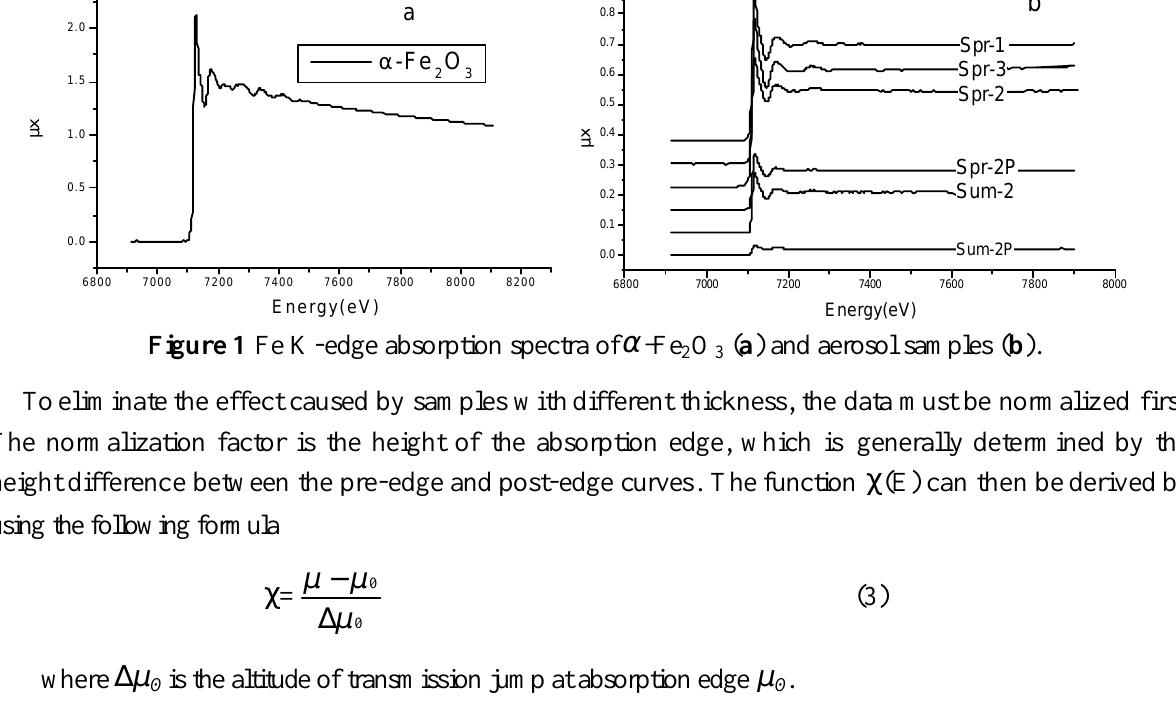
Figure 1 Fe K-edge absorption spectra of a - Fe